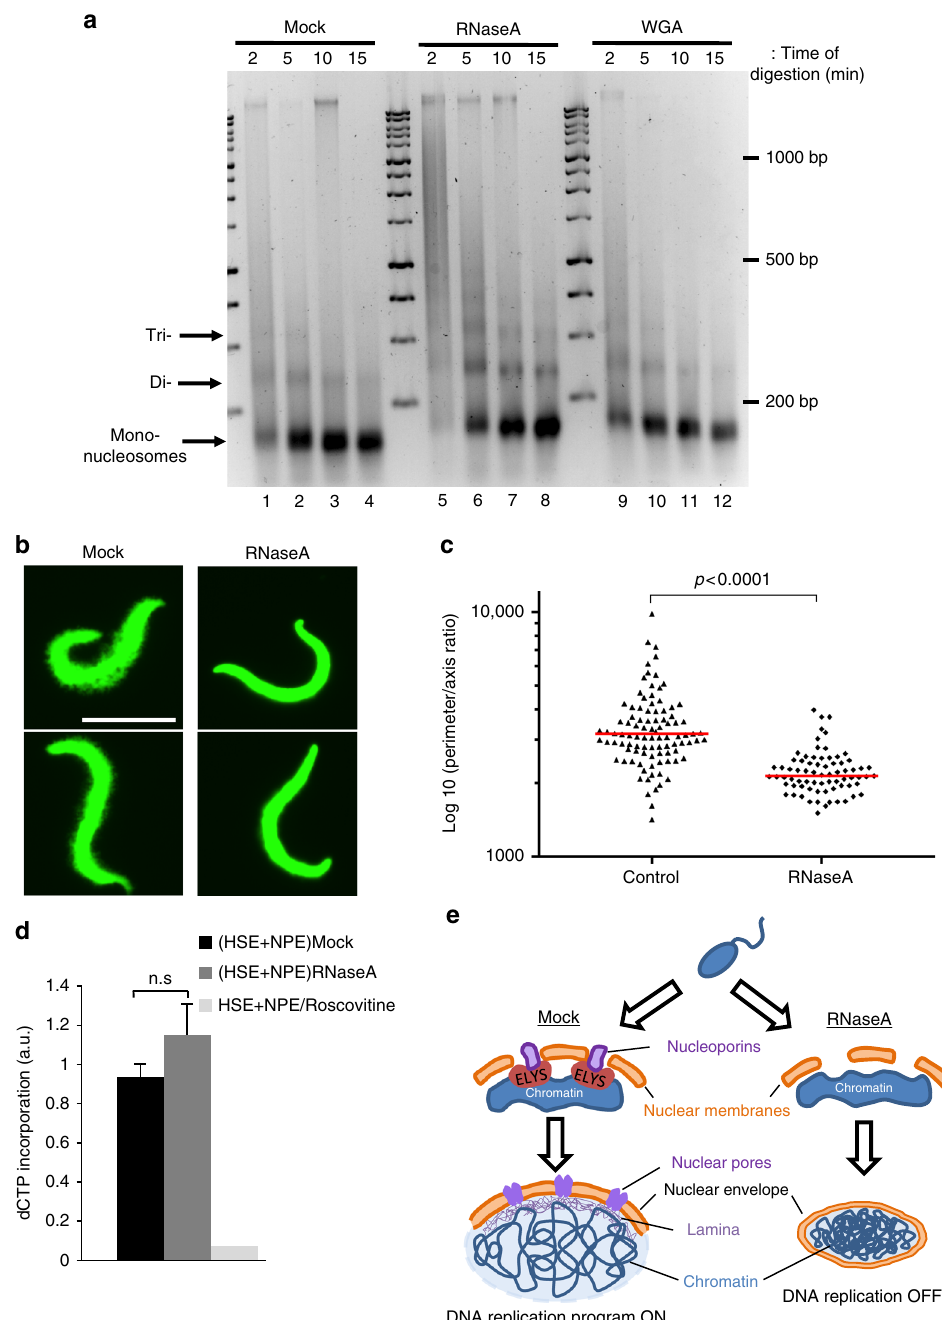
Fig. 6 RNAs modulate the higher-order chromatin structure. a Micrococcal nuclease (MNase) digestion assays of nuclei that were assembled in mock- and RNA-depleted extracts for 15 min. Black arrows indicate the ladder of mono-, di- and tri-nucleosomes. b Immuno fl uorescence images of histone H2B in nuclei treated with a moderate salt concentration after incubation in mock- or RNA-depleted X . laevis egg extracts for 15 min. Scale bar, 17 μ m. c Quanti fi cation of the chromatin perimeter-to-axis ratio in one representative experiment out of three. Mock-depleted extracts: n = 102 nuclei; RNase A- depleted extracts: n = 93 nuclei. A two-tailed Student t -test was performed to determine the p -value. d Quanti fi cation of three independent DNA replication assays (mean ± SD) in which sperm nuclei were incubated in mock or RNase A-treated HSE (for replication licensing) and then transferred to mock- or RNase A-treated NPE (for replication initiation). Nuclear membrane-free replication was monitored by autoradiography. A two-tailed Student ’ s t - test was performed to calculate the p -values; n.s., not signi fi cant. e Stepwise model of the major events leading to the replication initiation defect observed upon RNA depletion in egg extracts. Protamine removal and histone incorporation, two major steps during chromatin remodelling following fertilisation, occur normally both in the presence or absence of maternal RNAs. Newly formed chromatin in RNA-depleted extracts acquires a compact